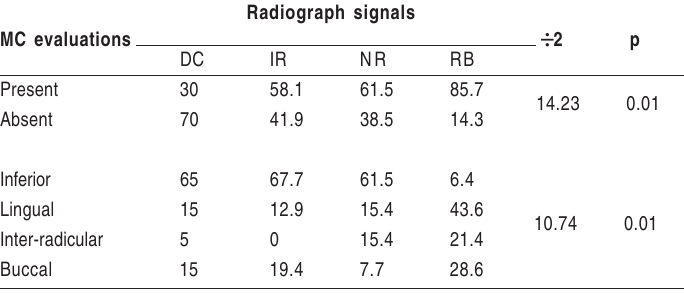
Table 1. Rates of direct contact between structures and the topographic relation of the mandibular canal (MC) regarding the radiographic signals.